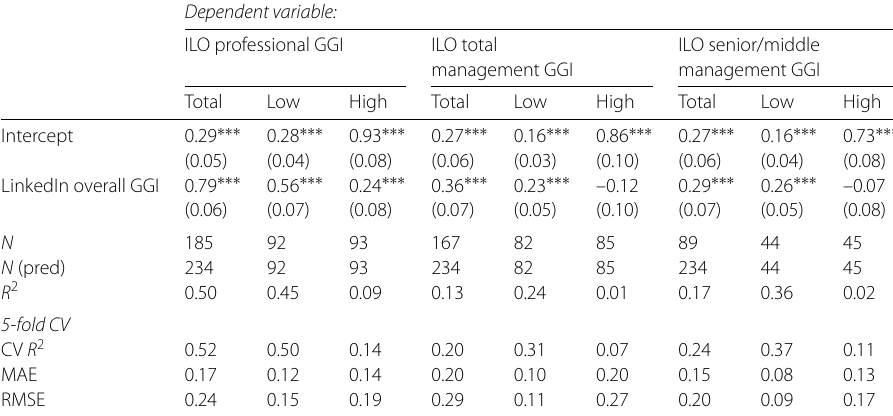
Table 4 Regression coefficients from the models predicting ILO GGIs from LinkedIn overall GGI for all countries (total) and countries with low (ILO GGI < median ILO GGI) and high (ILO GGI ≥ median ILO GGI) professional gender